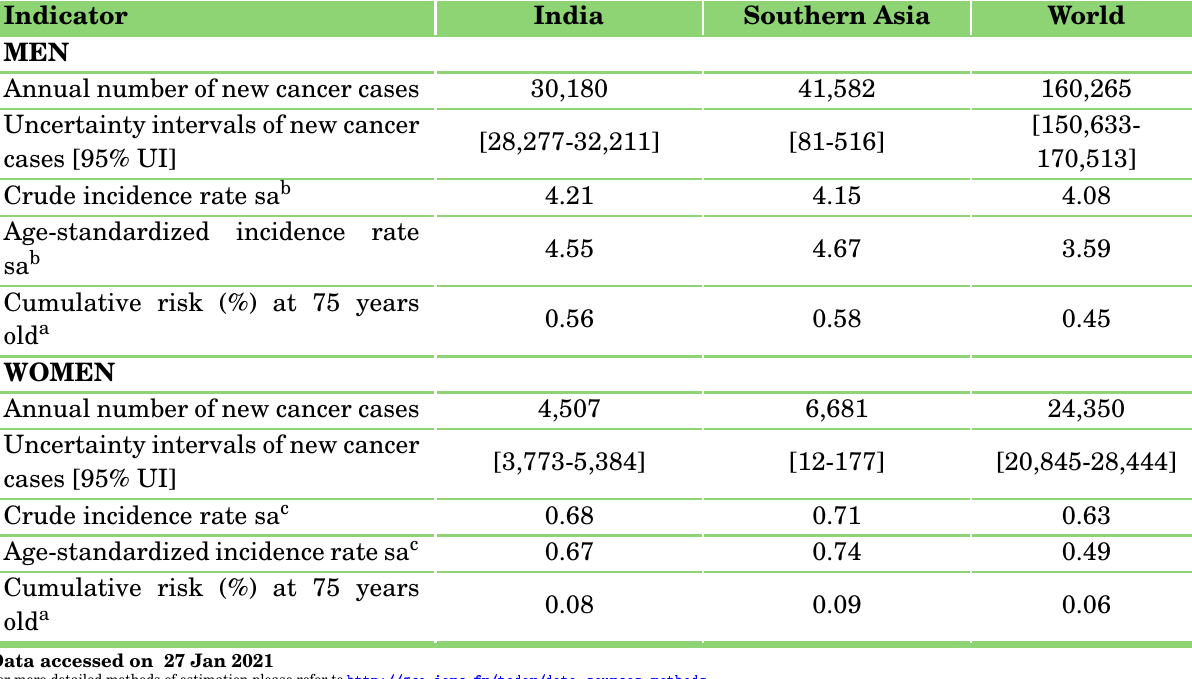
Table 19: Laryngeal cancer incidence in India (estimates for 2020)